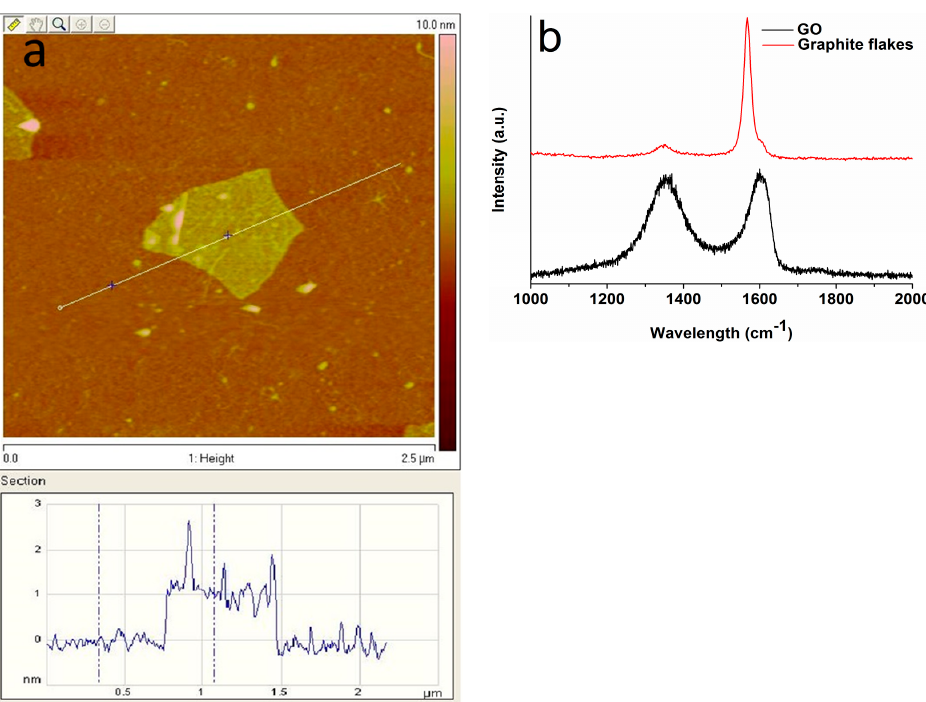
Figure 3. ( a ) AFM image of GO with height profile across a scan line and ( b ) Raman spectra of GO and graphite.